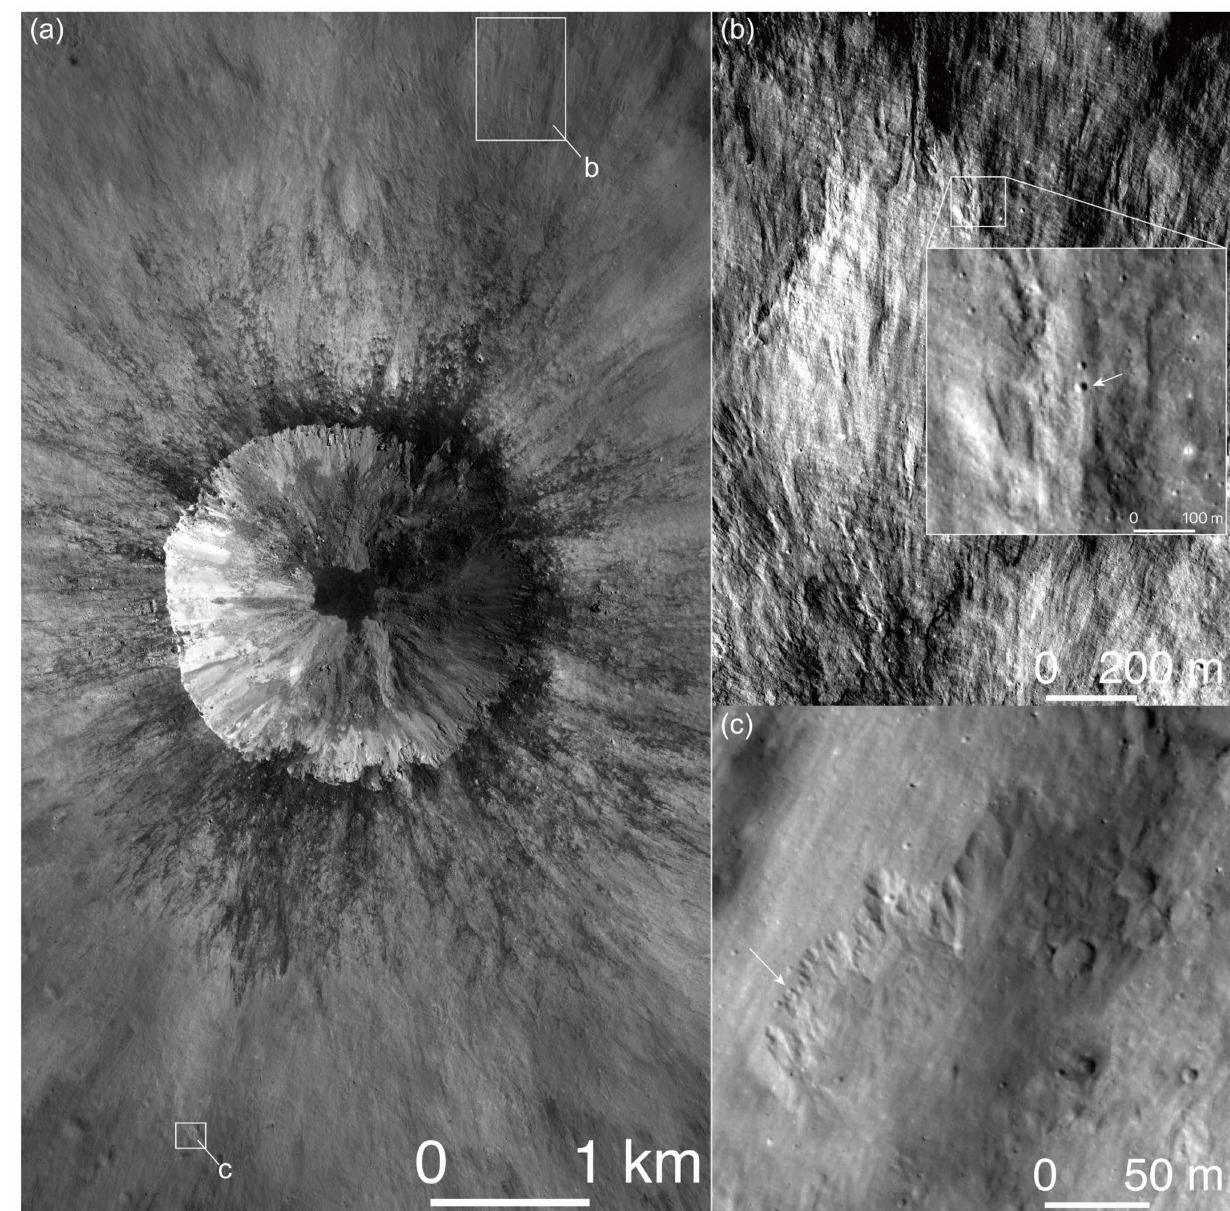
Figure 2. Self-secondaries and layers of ejecta deposits around a cold spot crater ( D = 2315 m) that is centered at 144.40 ◦ E, 17.68 ◦ S. Solar illumination is from the right, and north is up in all the panels. ( a ) Morphology of the crater. Darkish melt-rich deposits are emplaced on top of bright granular ejecta. ( b , c ) Embayment of self-secondaries by post-deposition flows that are developed in the layers of ejecta deposits (white arrows). The locations of the two frames are marked in panel ( a ). IDs of data used in this figure are compiled in the Supplementary